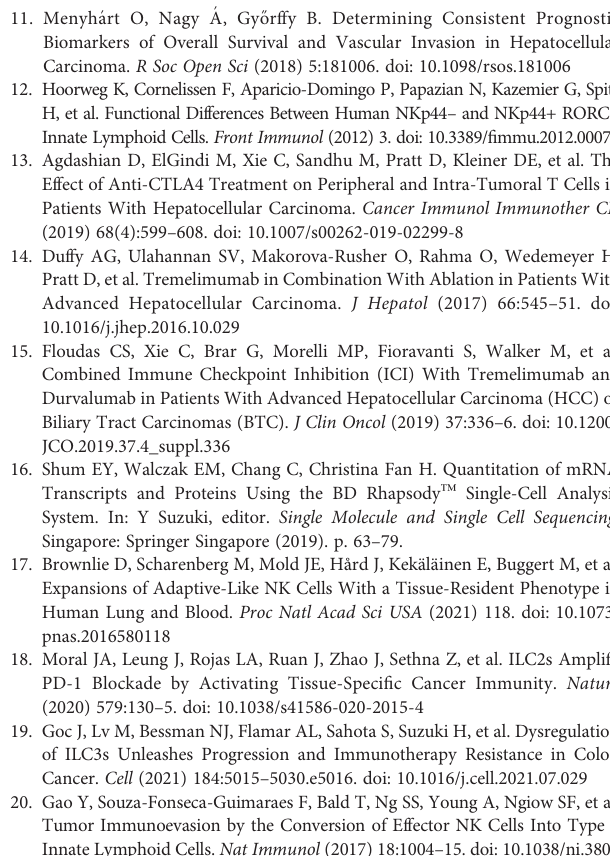
Supplementary Figure 4 | (A) Frequencies of ILC subgroups over the course of treatment with immunotherapy using tremelimumab, split by response to therapy. C=cycle with C1 representing baseline before therapy. (B) Frequencies of ILC subgroups over the course of treatment with immunotherapy using tremelimumab in combination with durvalumab, split by response to therapy. C=cycle with C1 representing baseline before therapy. (C) Analysis of recurrence-free survival in TCGA liver cancer cohort of all patients using KaplanMeier-plotter. Survival prediction based on signatures derived from transcripts of KLRF1 high ILCs or CD6 + ILC1s in PBMCs. Table showing risk strati fi cation of patients. Supplementary Table 1 | DEGs of clusters from unbiased graph-based clustering of ILCs in